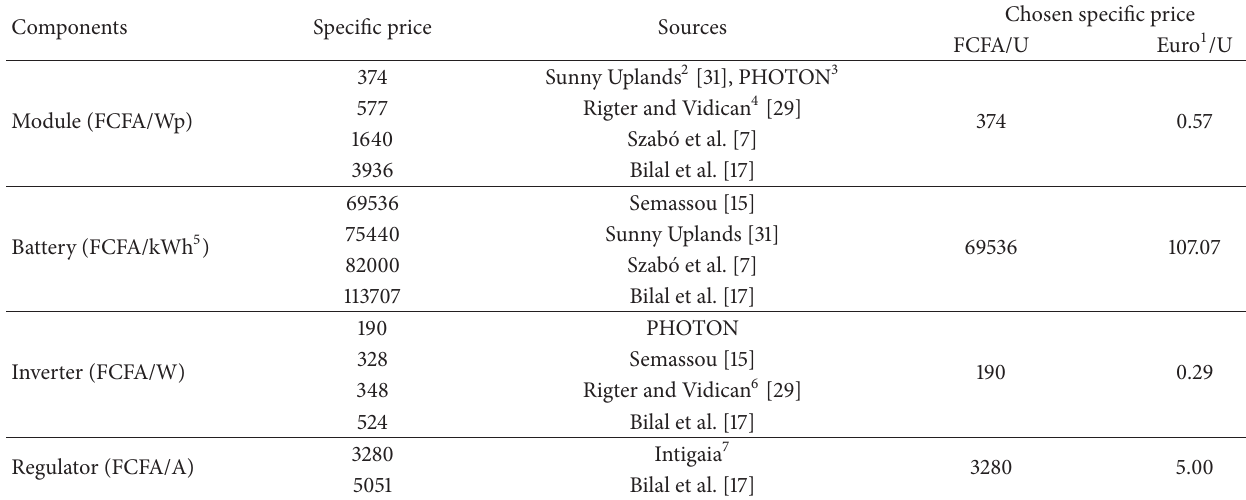
Table 1: Solar energy system’s components costs.